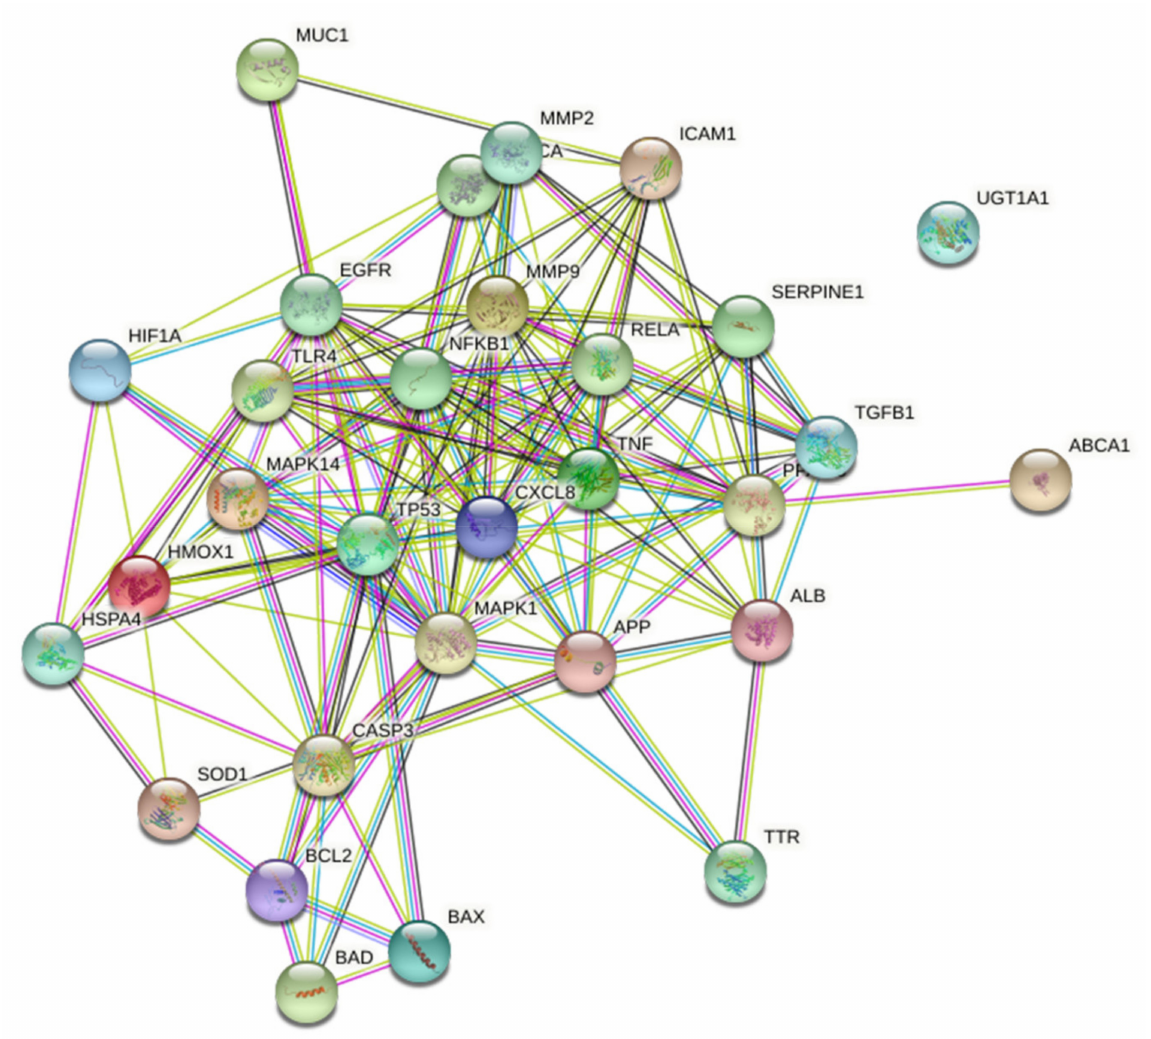
Figure 3. Protein–Protein Interaction (PPIs) network using STRING database. Two main targets, TP53, which showed the highest degree of 20, followed by MAPK1 (Degree 19) were identified.